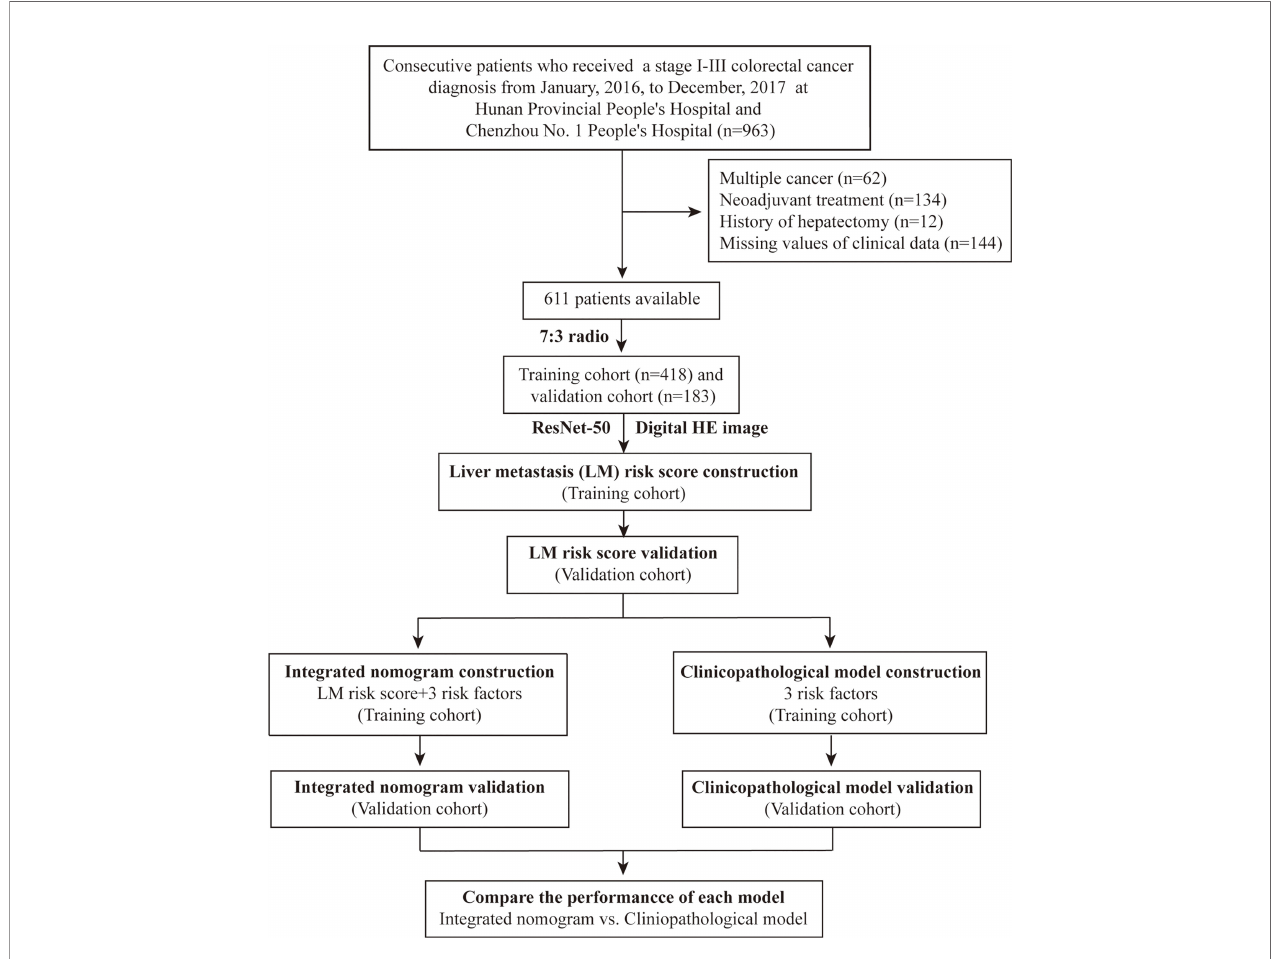
FIGURE 1 | The overall process of this